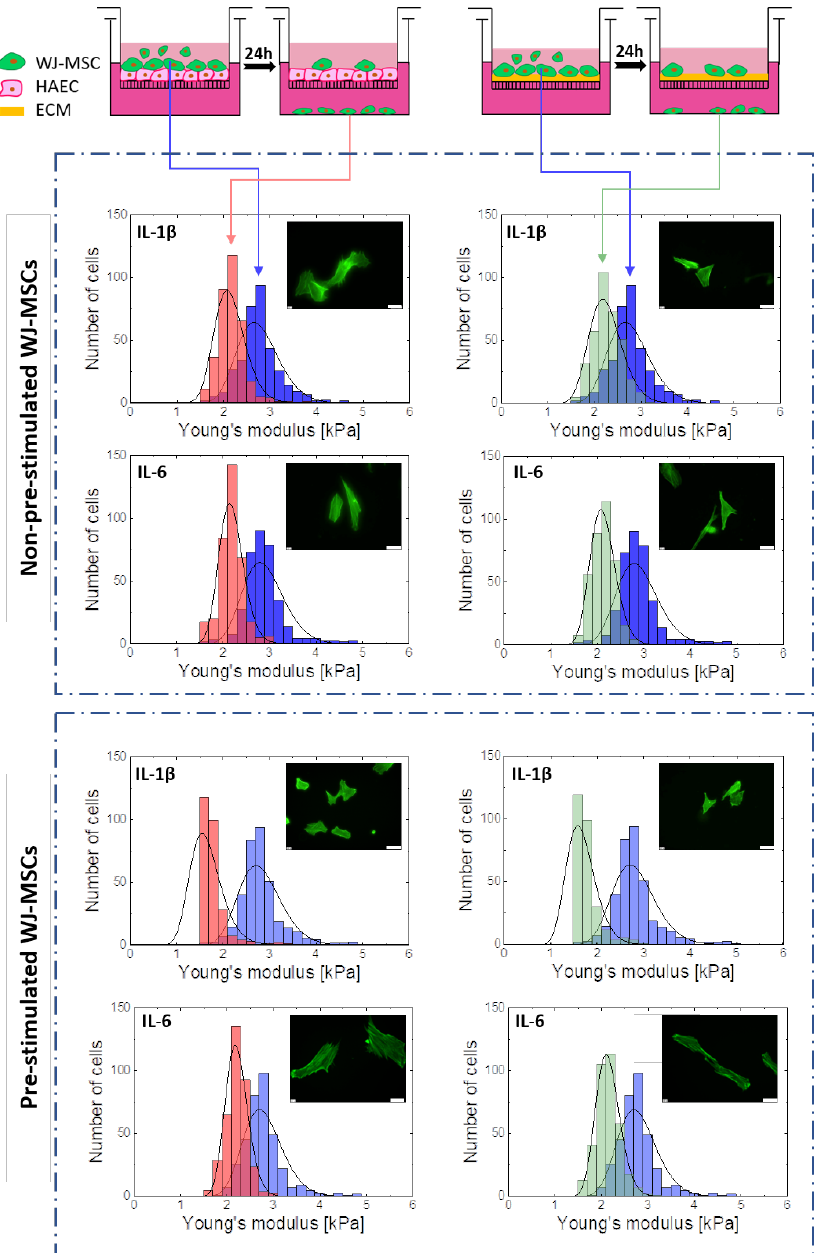
Figure 8. Comparison of the elasticity of WJ-MSCs before (blue) and after transendothelial migration (TEM) (red), and before (blue) and after the invasion (green) towards proinflammatory cytokines. The elasticity parameter distribution for 360 cells isolated from six donors. Young’s modulus calculated for indentation depths 300 nm. Gauss distribution fits (black solid curves). Insets—fluorescence images of subpopulation WJ-MSCs with migration potential (magnification 400 ×, Scalebar = 50 µm).